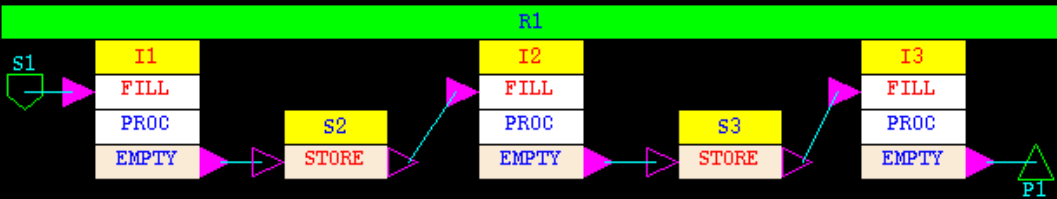
Figure 7. Example 2 Gantt chart.